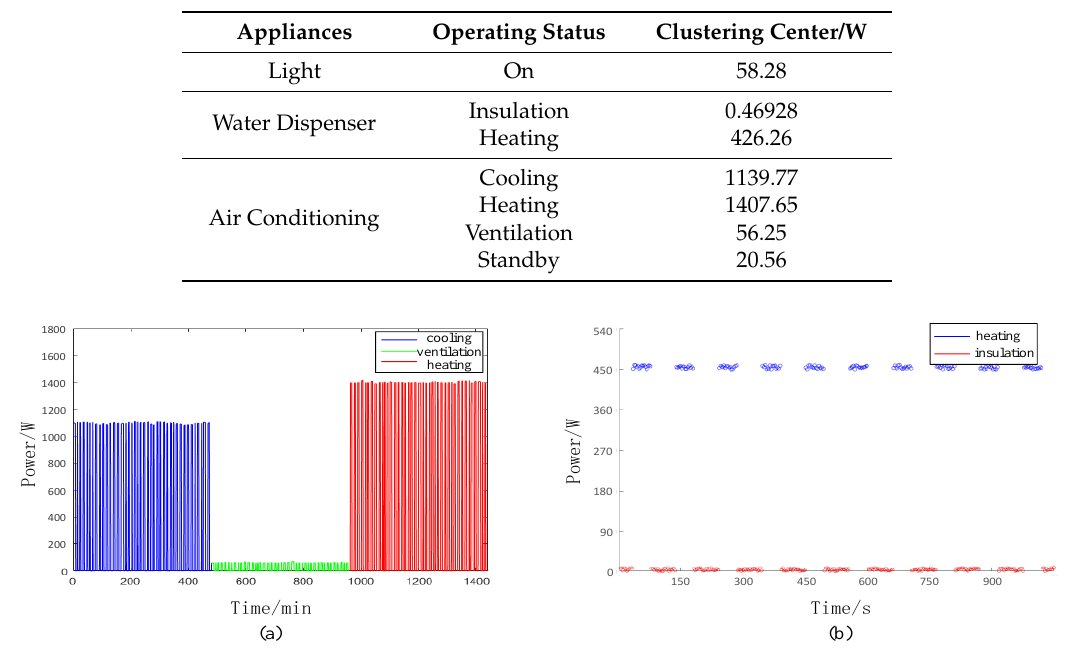
Table 1. Reference values of operating status and characterized power.